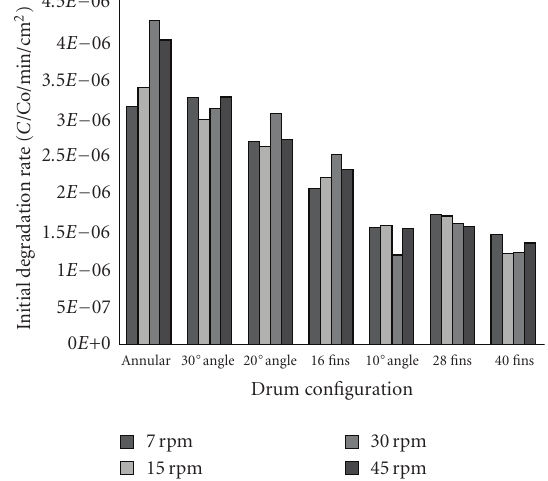
Figure 4: Initial degradation rate per unit surface area for the various drum configurations.